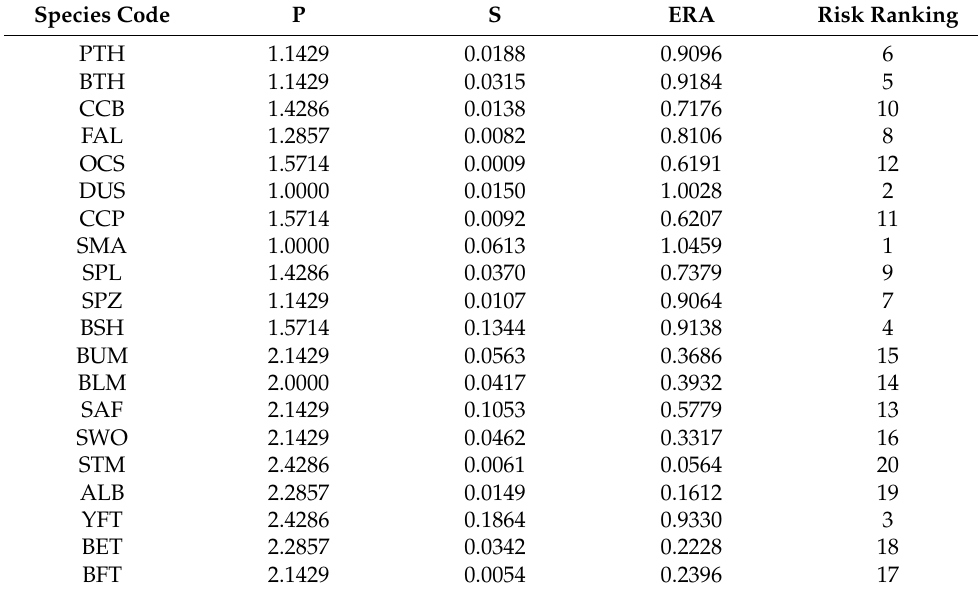
Table 5. Ecological risk assessment results of the 20 pelagic species in the Northwest Pacific